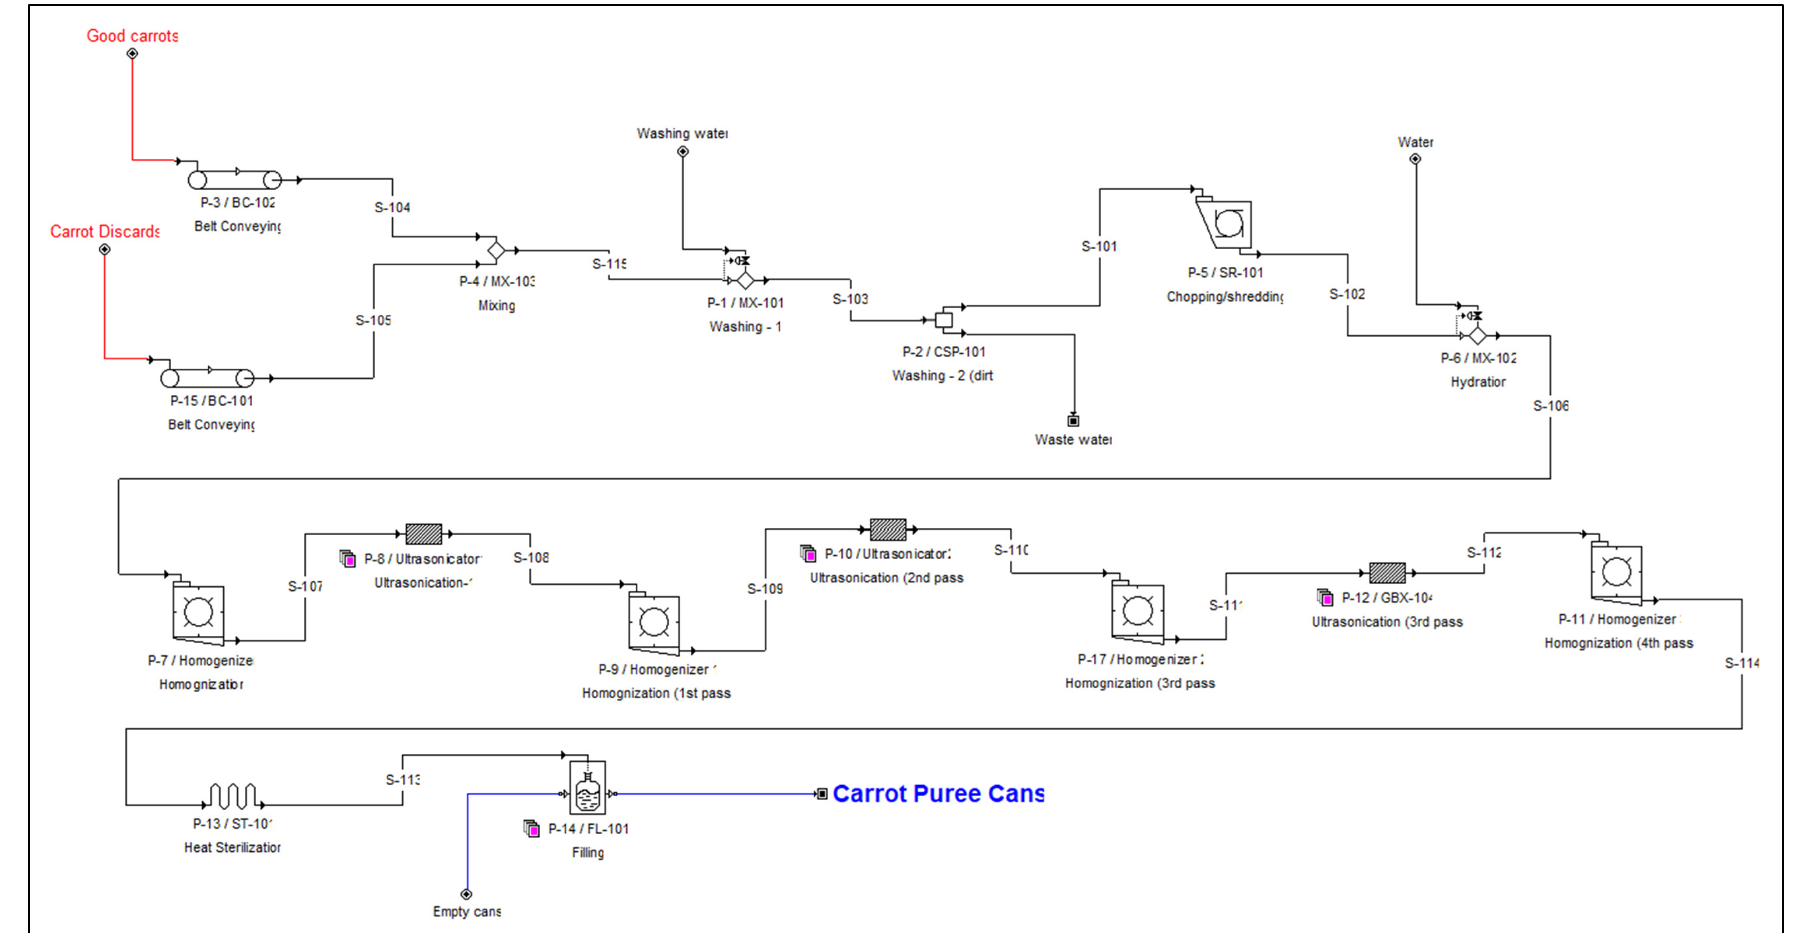
Figure 1. Flowsheet of a process model (case 2: mix of PDCs and graded carrots (50:50)) developed in SuperPro.